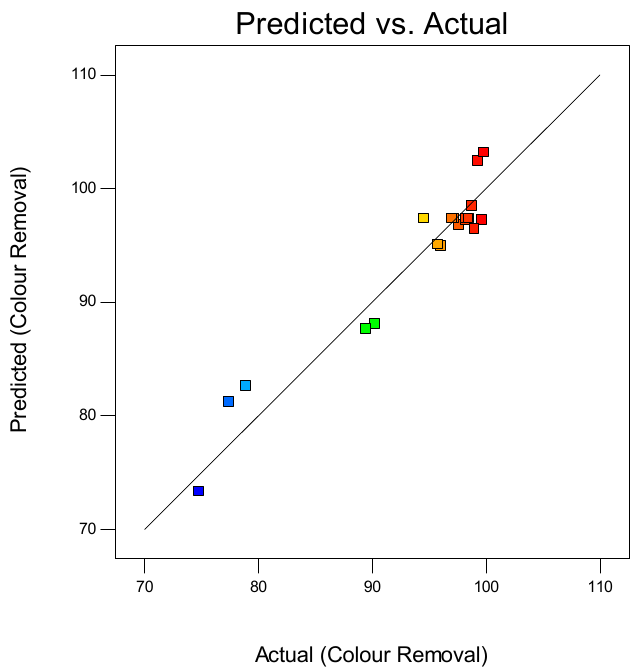
Figure 6. Experimental actual vs. predicted values of colour removal.